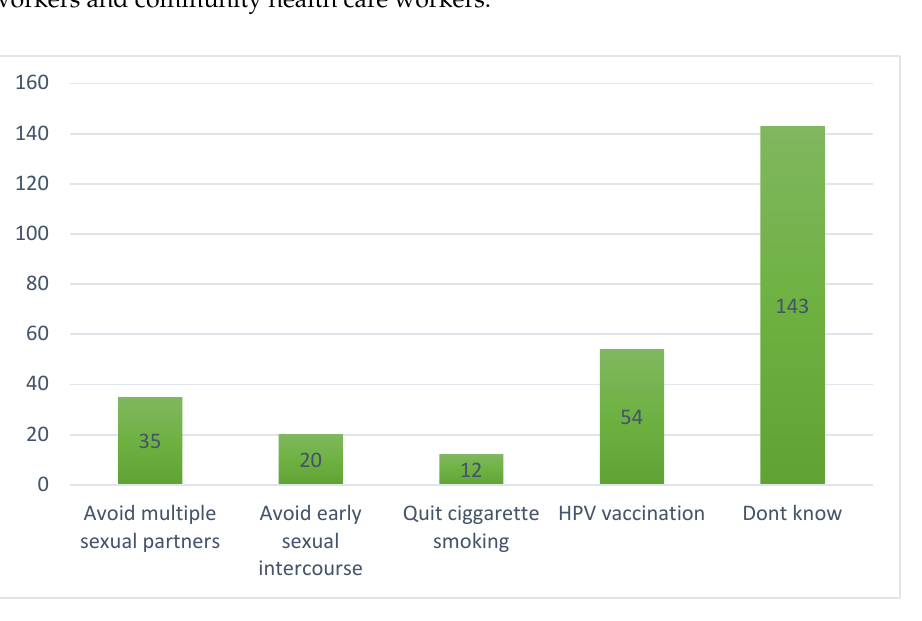
Figure 2. Prevention of cervical cancer.